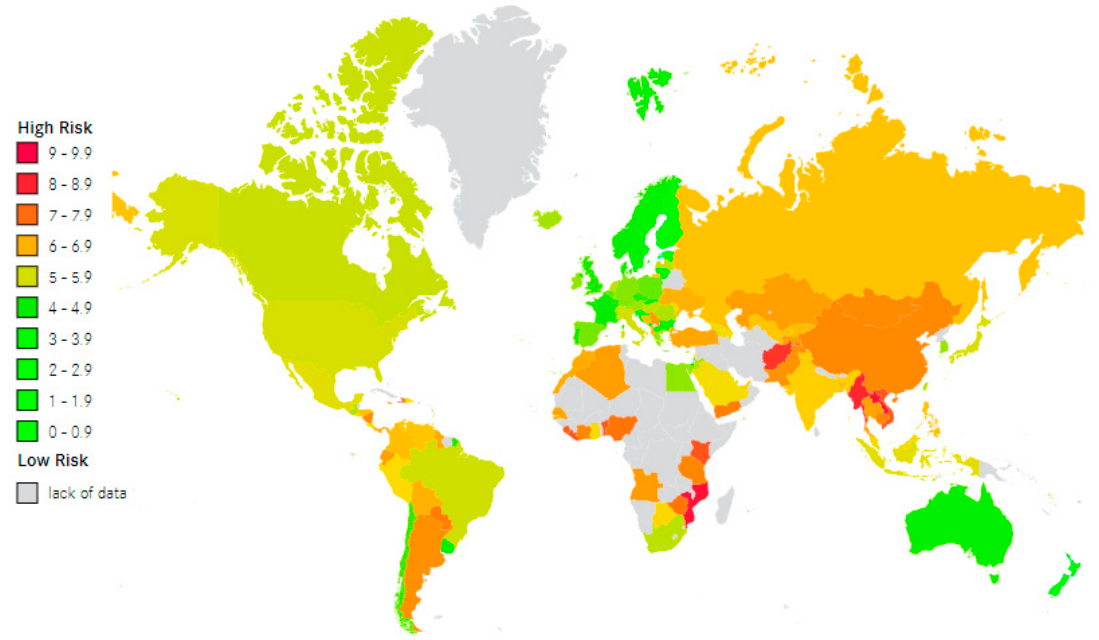
Figure 1. Money Laundering / Terrorist Financing risk scores distribution.